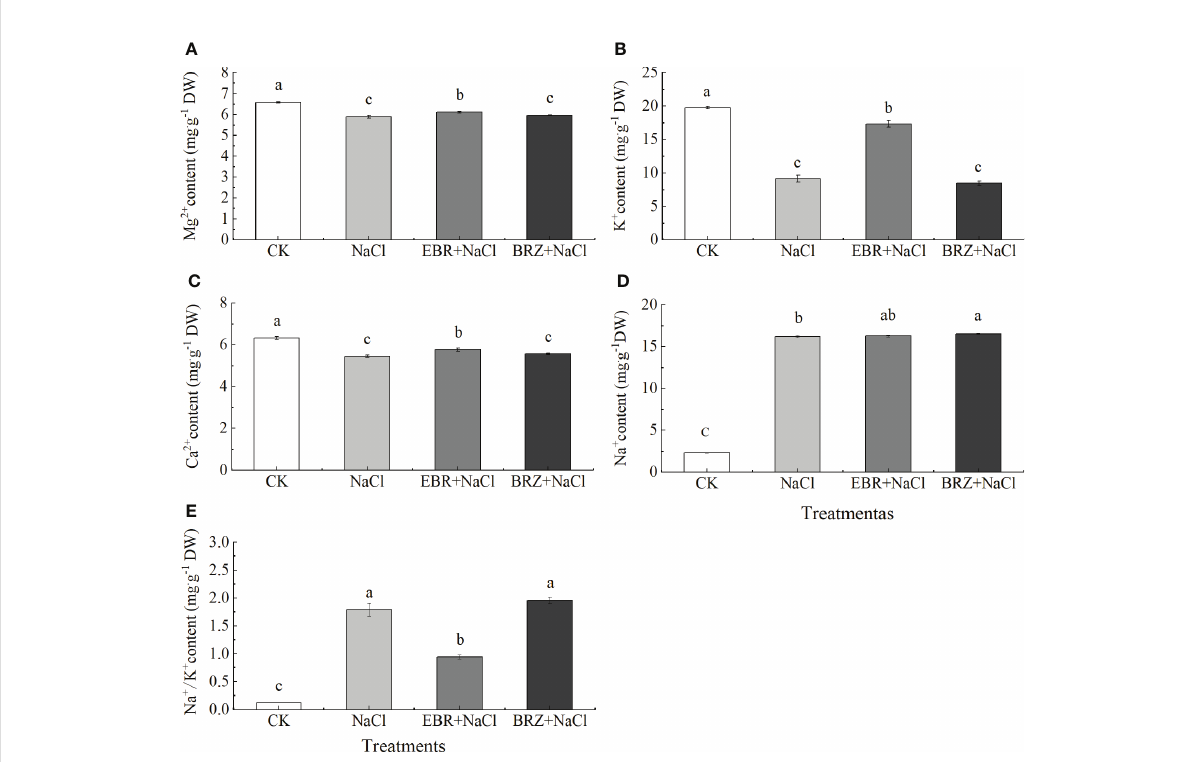
FIGURE 7 Effect of exogenous EBR on the content of Mg 2+ (A) , K + (B) , Ca 2+ (C) , Na + (D) , Na + /K + (E) ions in the leaves of cucumber seedlings under salt stress. Data are means ± SE of three replicates. Different letters indicate signi fi cant differences at P < 0.05 according to Dun ’ an ’ s multiple range test.